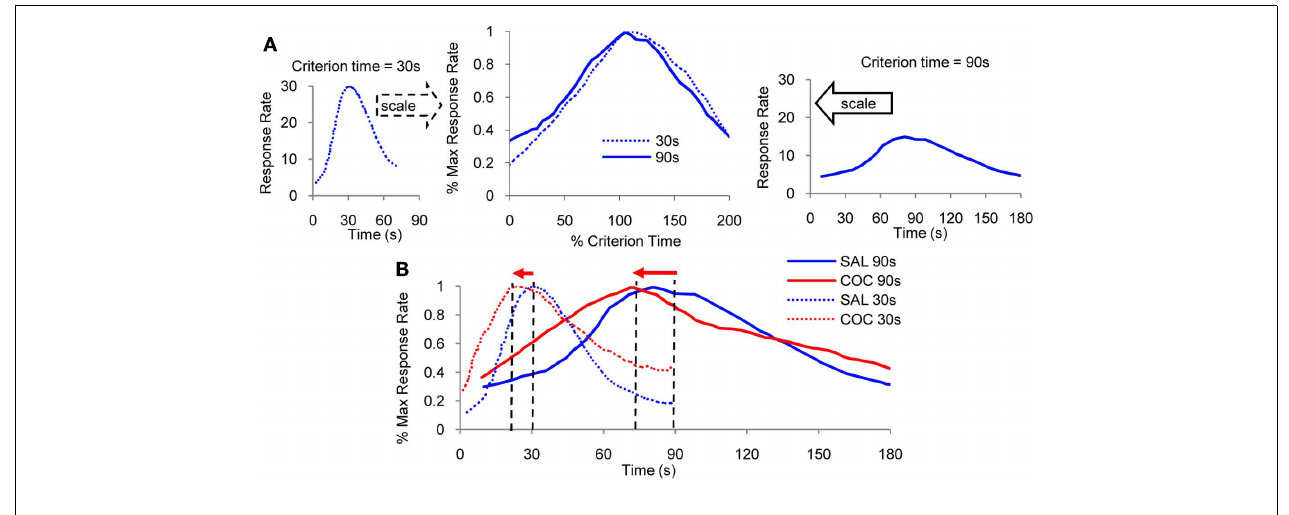
duration on the horizontal scale, response functions for the two criteria overlap (middle panel). (B) Administration of indirect dopamine agonist cocaine results in an immediate, scalar (proportional) leftward shift in response